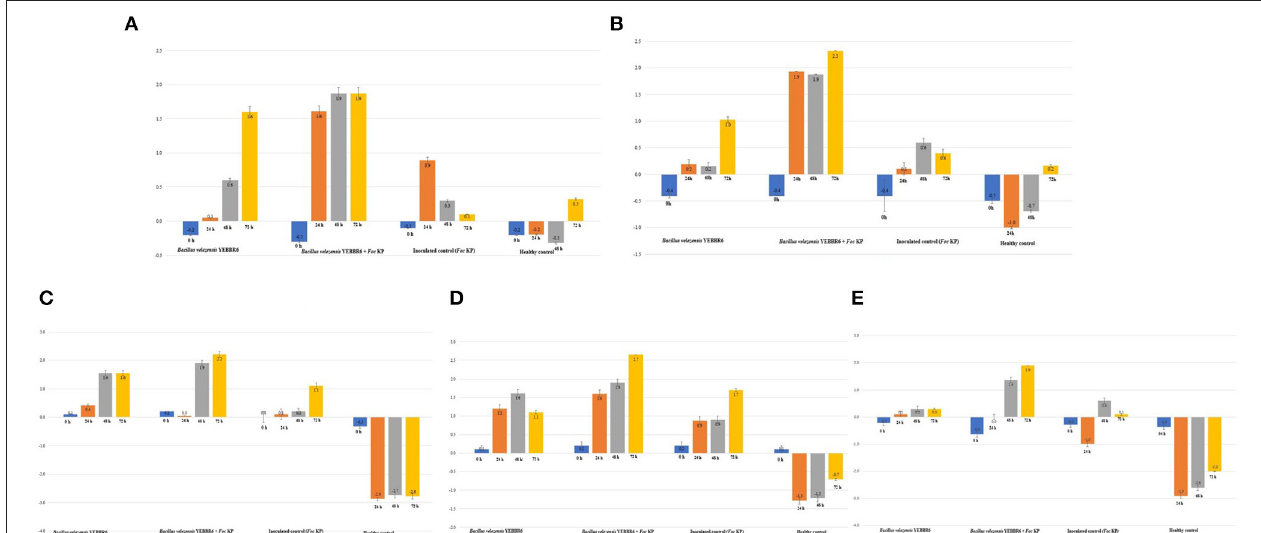
FIGURE 5 | (A) Expression pattern of WRKY 33 transcription factor in biohardened banana cv. Karpooravalli (ABB) under mono, di, and tritrophic interactions at different time periods. (B) Expression pattern of MAPK in biohardened banana cv. Karpooravalli (ABB) under mono, di, and tritrophic interactions at different time periods. (C) Expression pattern of CERK 1 in biohardened banana cv. Karpooravalli (ABB) under mono, di, and tritrophic interactions at different time periods. (D) Expression pattern of LOX in biohardened banana cv. Karpooravalli (ABB) under mono, di, and tritrophic interactions at different time periods. (E) Expression